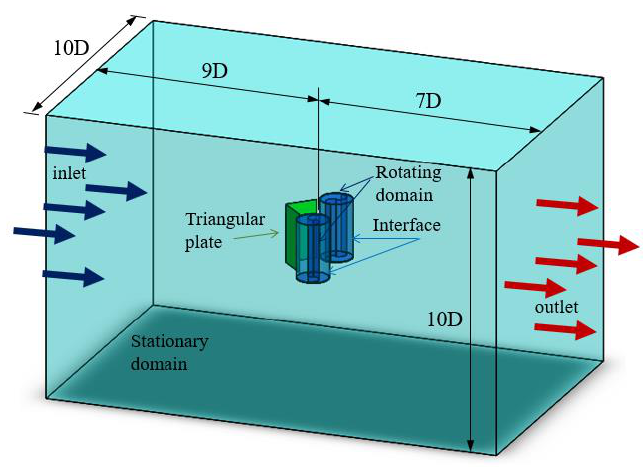
Figure 2. Numerical domains and boundaries.